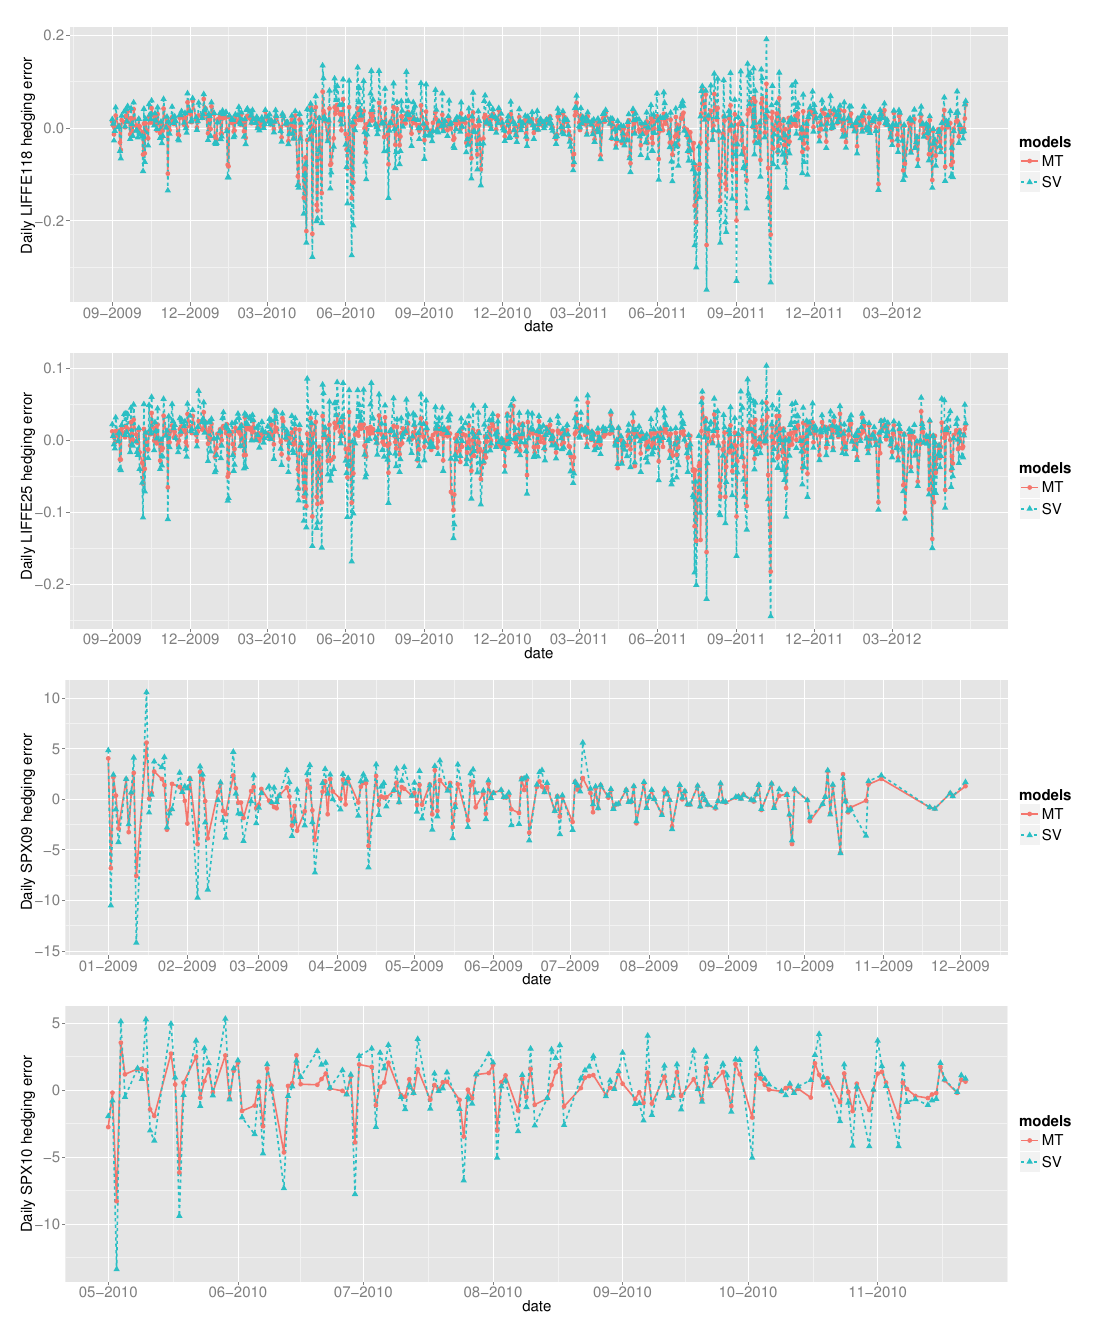
Figure 1. We plot the daily market hedging error as a function of time for Heston’s model (dashed blue) and the overconstrained L 2 Markov Tree model (solid red), applied to the four data sets LIFFE118, LIFFE 25, SPX09, and SPX10 (top to bottom). Errors for LIFFE and SPX data sets are in Euros ( e ) and USD ($), respectively. The results are discussed in detail in Section